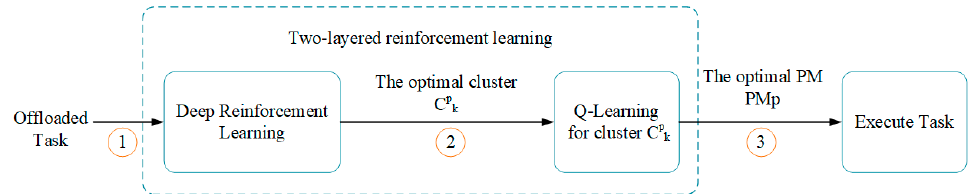
Figure 6. The structure diagram of two-layered reinforcement learning (TLRL) algorithm.